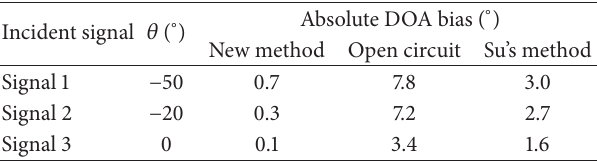
Table 2: Absolute DOA bias for the wideband signals in three